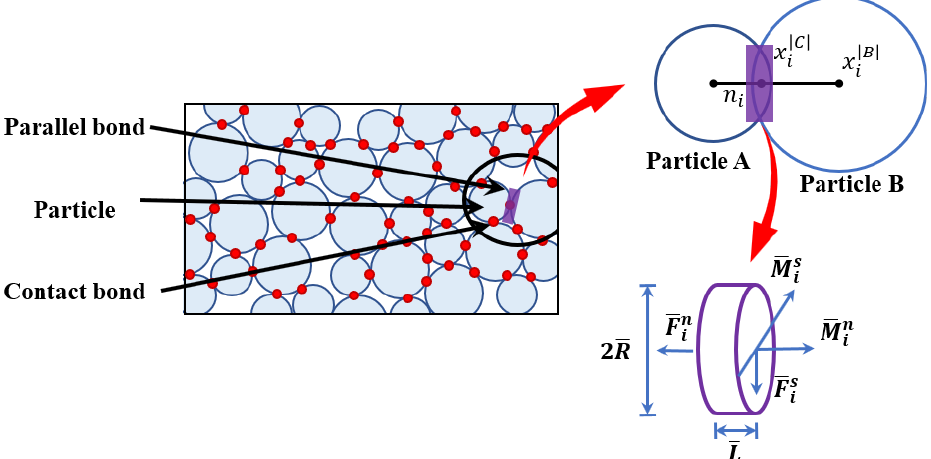
Figure 5. Force-displacement behavior of bonded-particle model. Modified after Potion and Cundall (2004) [13].